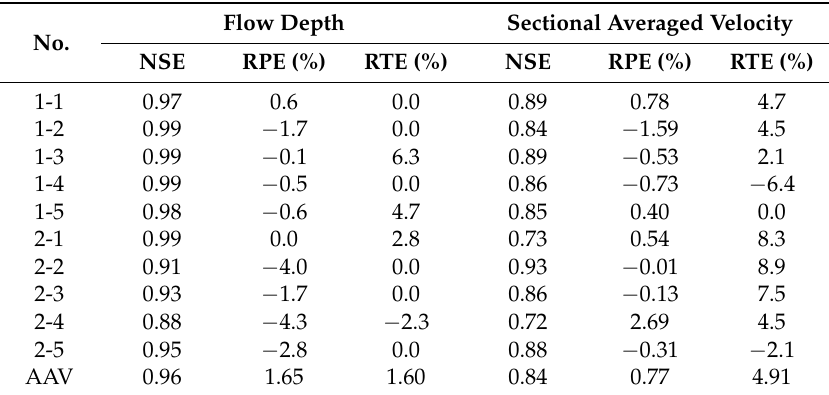
Table 5. The NSEs, RPEs, and RTEs of the modified SVN